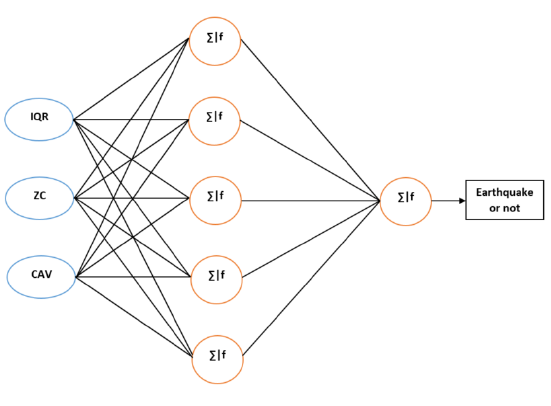
Figure 2. The ANN model with three inputs with one hidden